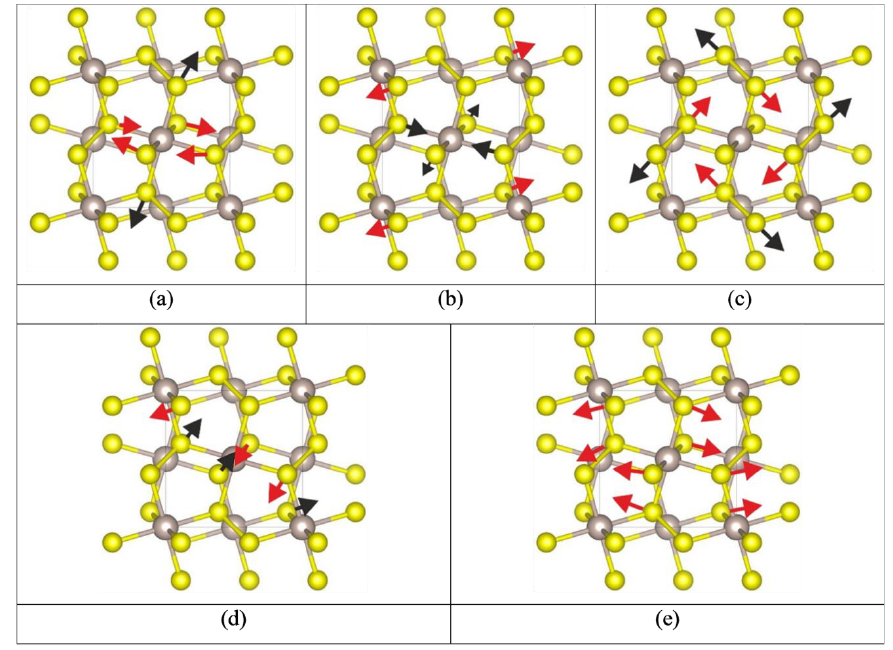
Figure 8. Schematic representation of vibrational modes: ( a ) E g 370.5 cm − 1 , ( b ) T g 372.1 cm − 1 , ( c ) A g 386.8 cm − 1 , ( d ) T g 404.9 cm − 1 , ( e ) T g 434.7 cm − 1 . 386.8 cm − 1 , ( d ) T g 404.9 cm − 1 , ( e ) T g 434.7 cm − 1 .